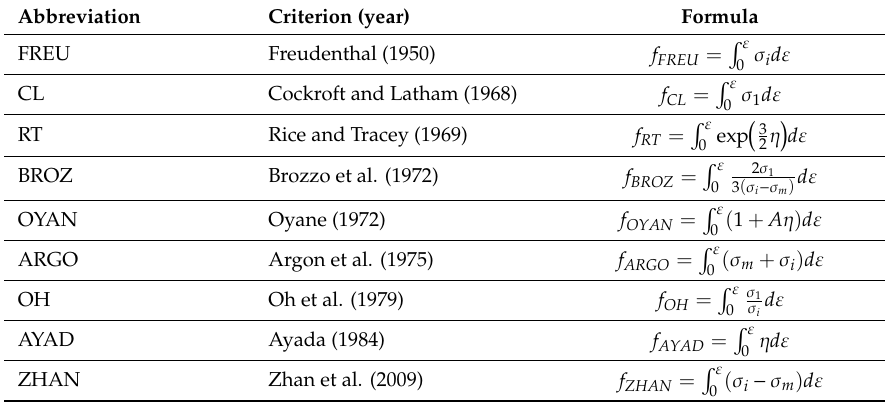
Table 1. Selected criteria of ductile fracture used for the presented analysis [22–30].